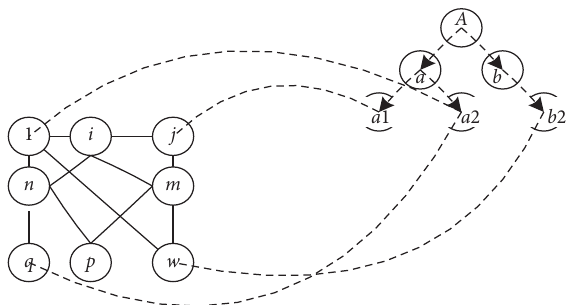
Figure 2: Multilayer knowledge network